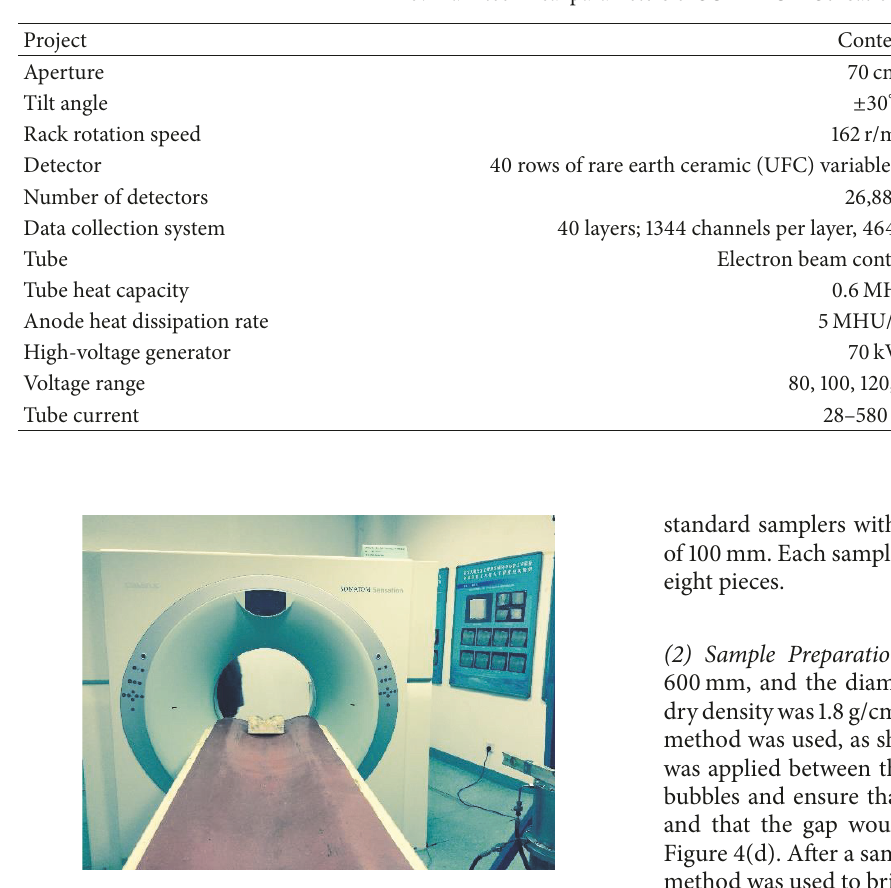
Figure 2: CT visualisation